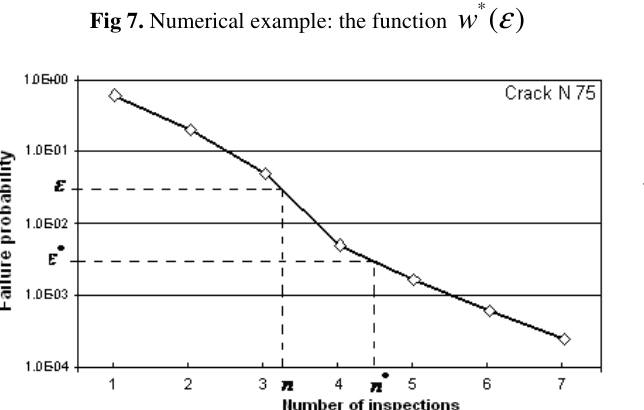
Fig 7. Numerical example: the function